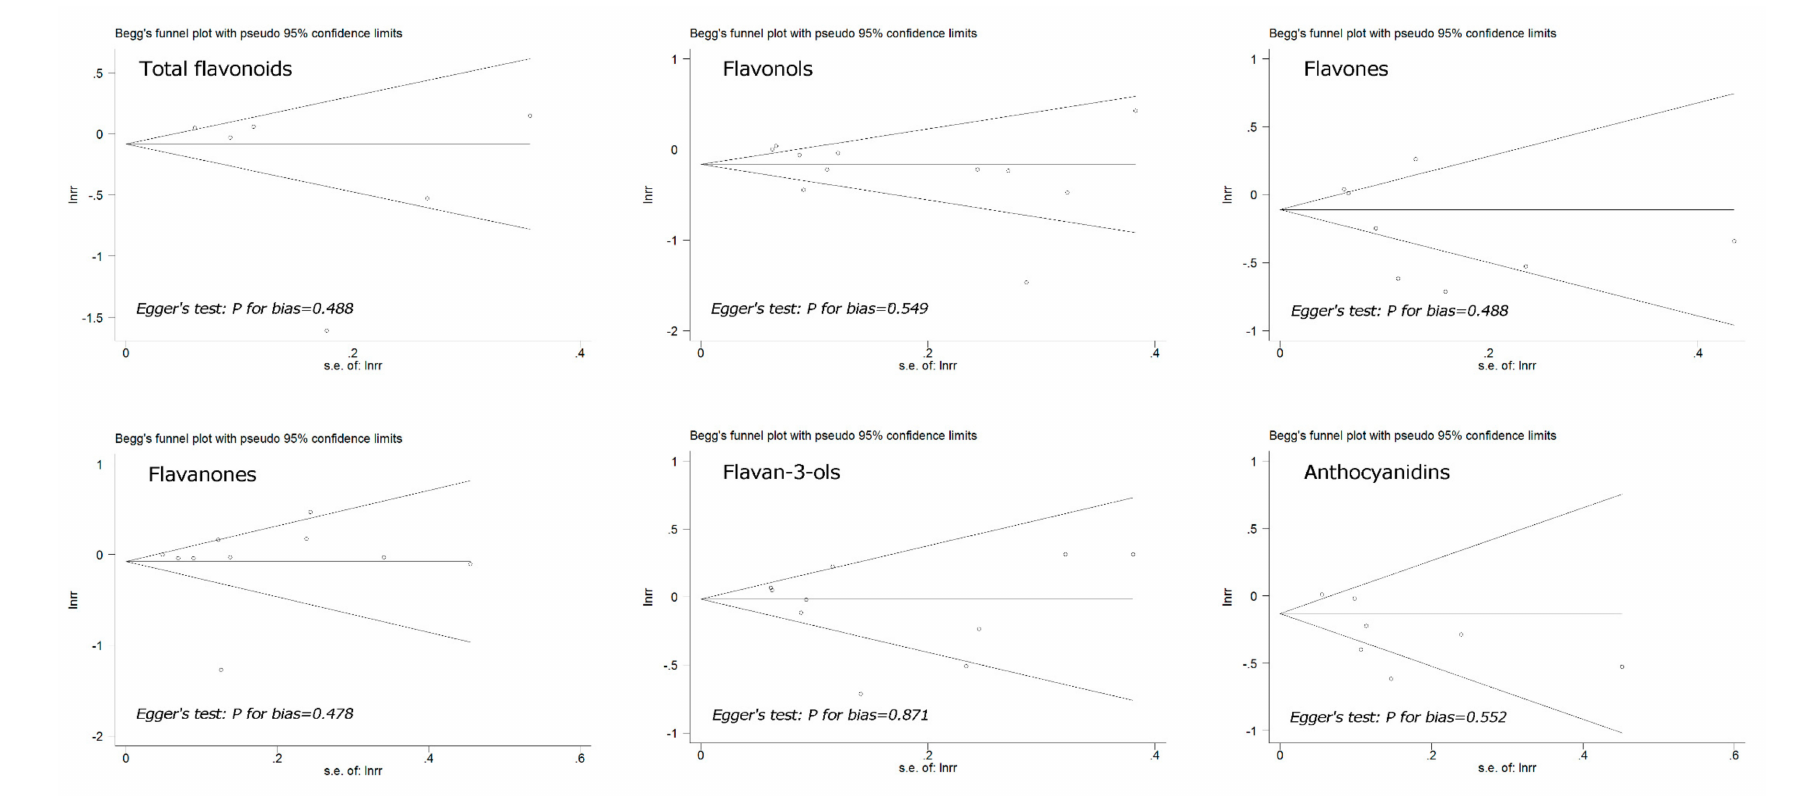
Figure 3. Begg’s funnel plot with pseudo-95% confidence limits for the RR of colorectal cancer and flavonoids intake (highest compared with lowest category of intake). Publication bias was evaluated with the use of funnel plots and with Egger’s regression asymmetry test ( p < 0.1 was considered representative of statistically significant publication